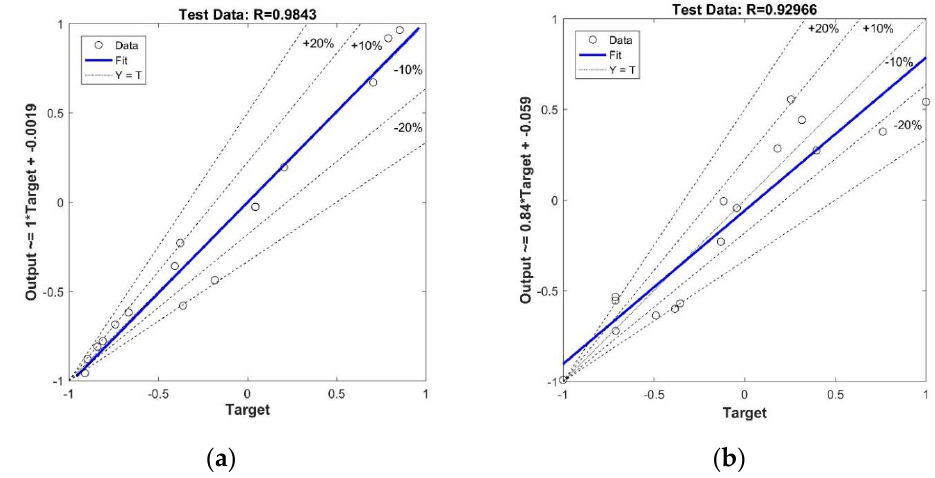
Figure 9. Correlation between real and predicted UCS ( a ) and EM ( b ) by ANFIS for test datasets.